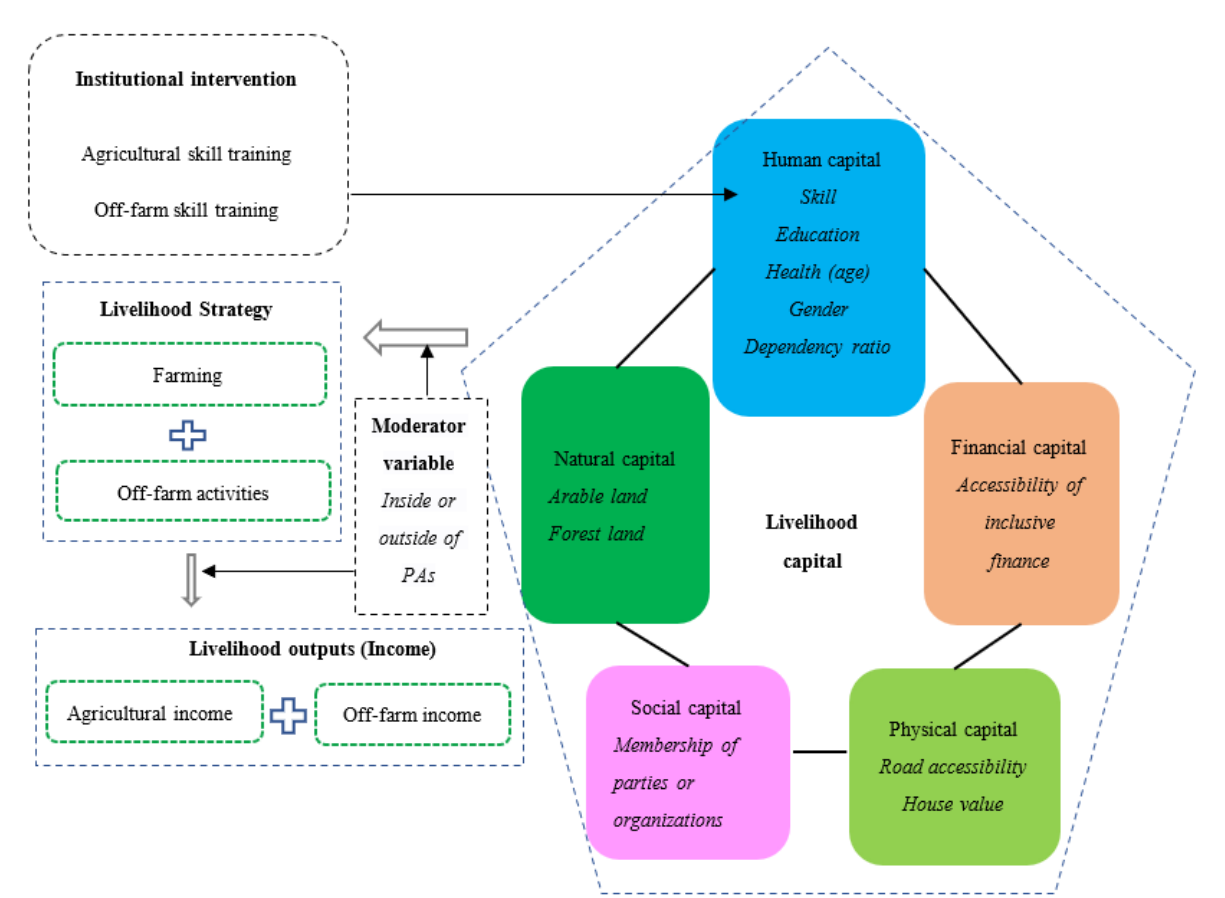
Figure 1. Conceptual framework of this study.